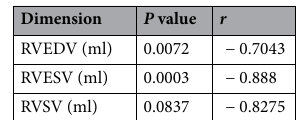
Table 8. Multivariate analysis between EF % and ventricular chamber volumes in athletes.